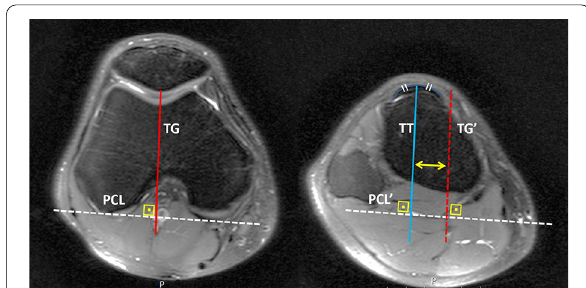
Fig. 5 Measurement of tibial tubercle (TT) to trochlear grove (TG) was performed on two overlapping axial images. PCL, posterior condylar line; TG, perpendicular line from deepest point of trochlear groove to posterior condylar line; TG, perpendicular line from the tibial tubercle to posterior condylar line. TT–TG distance is the distance between red and blue